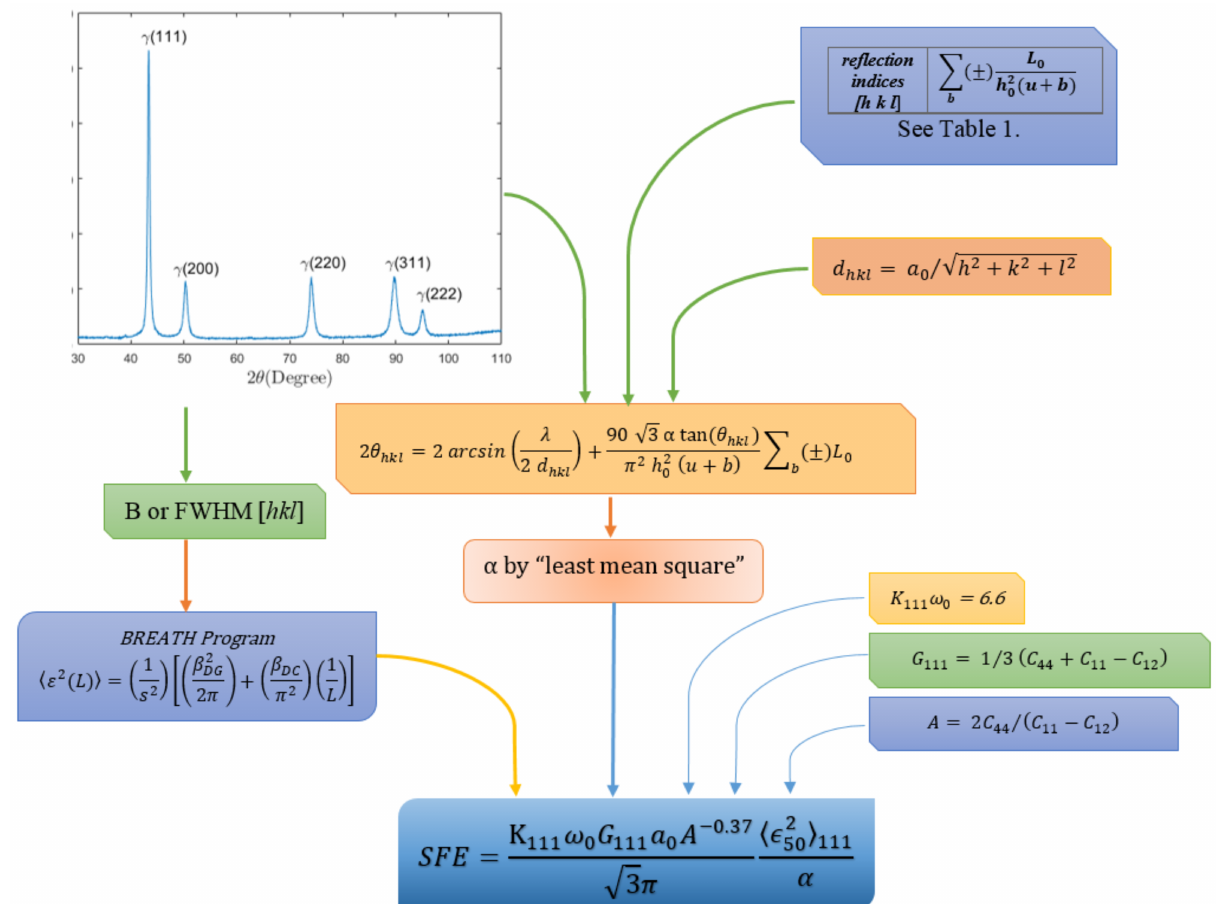
Figure 4. Chart to calculate the SFE from XRD and material elastic constants. In polycrystalline metals, the broadening and shift of the diffraction profiles are the product of plastic deformation. The broadening of the diffraction profiles is due to micro- deformations, stacking faults and change in the size of the lattice parameter. Peak shift is the result of stacking faults, residual stresses, and variations in crystallite size due to the interstitial or substitutional atoms. Through mathematical models, it is possible to separate the contribution from the factors that cause the shifting and broadening of the peak, as we will see in the following